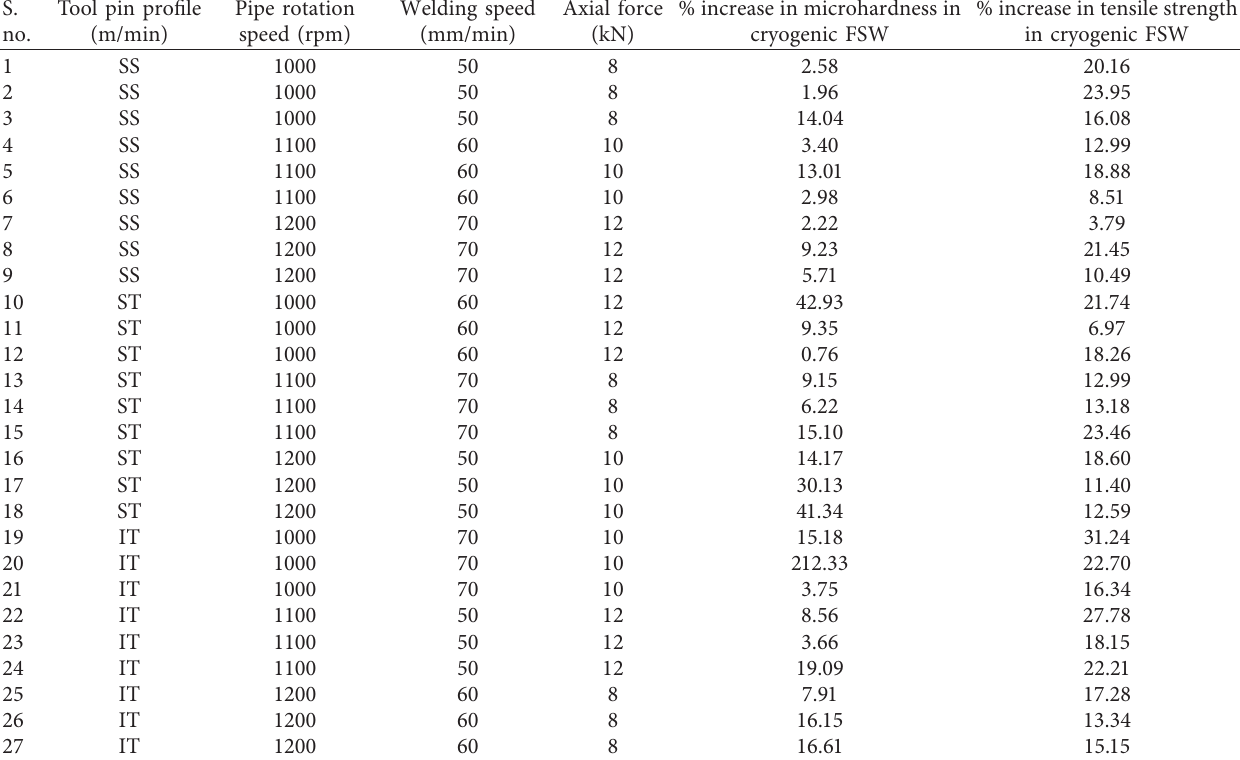
Table 9: Effect of cryogenic over dry friction stir welding for AA 7075 aluminium alloys.